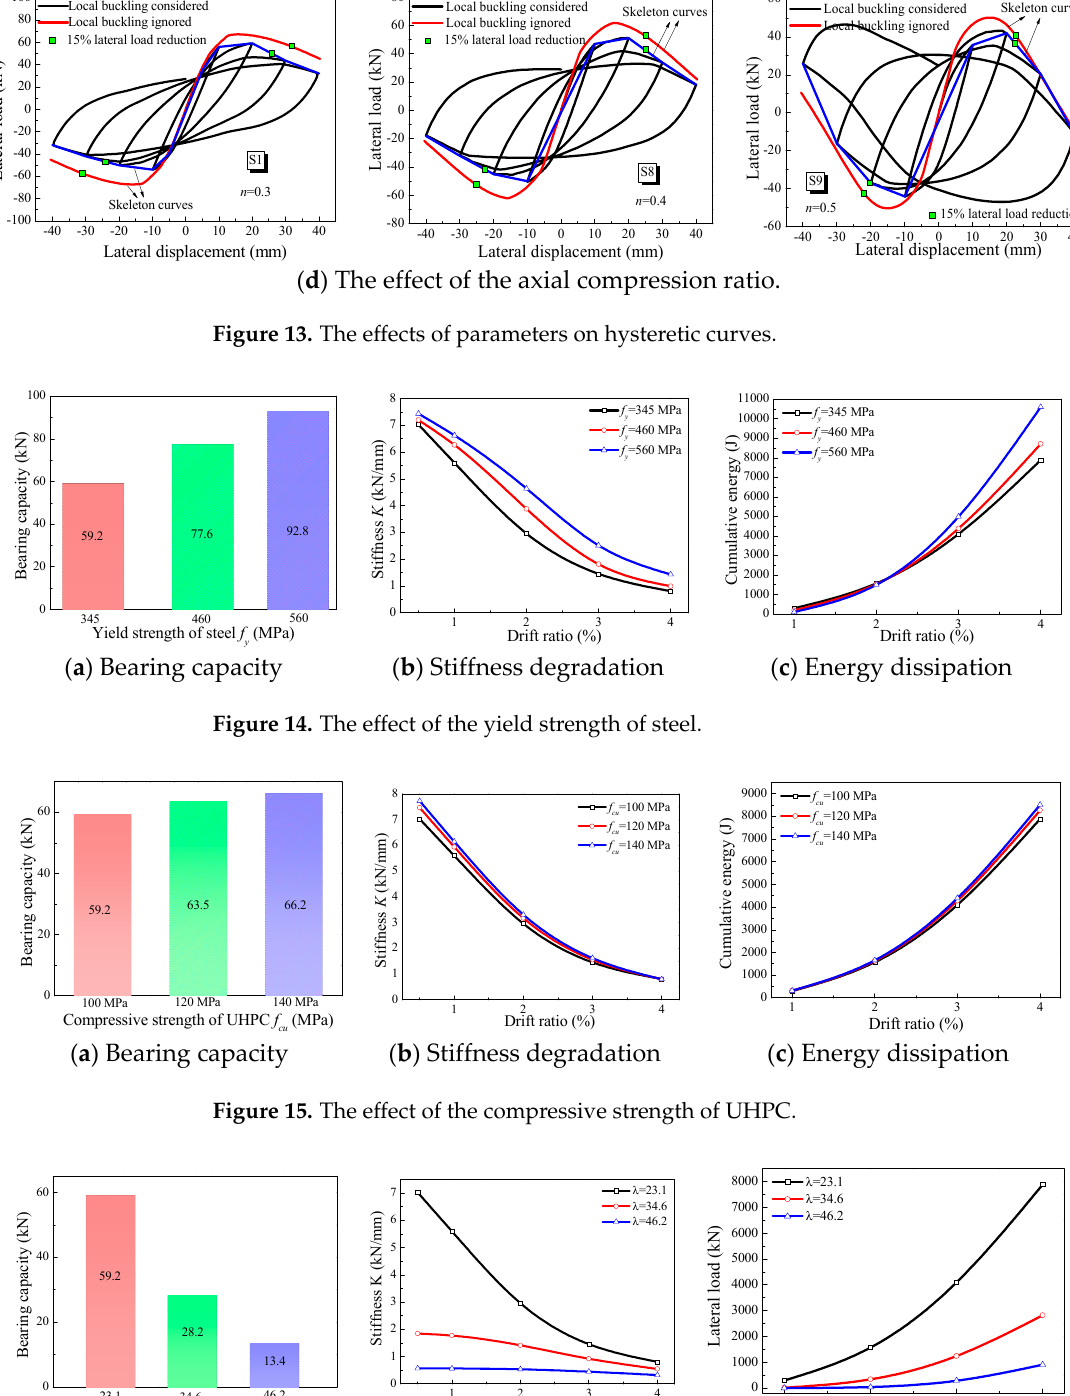
Figure 17. The e ff ect of the axial compression ratio. Table 3. The parameters of the columns for numerical analysis. Specime n